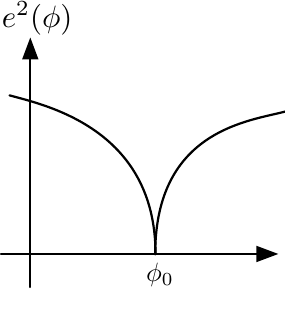
Figure 1. (a) Leading contributions to non-analytic couplings near a singular point in the moduli space of a 5d theory, in the case where the particle becoming massless is a fermion (similar diagrams apply to bosons). (b) Behavior of a 5d gauge coupling e 2 ( φ ) = 1 / f ( φ ) near a singular point in the moduli space φ = φ 0 where massless charged particles appear.